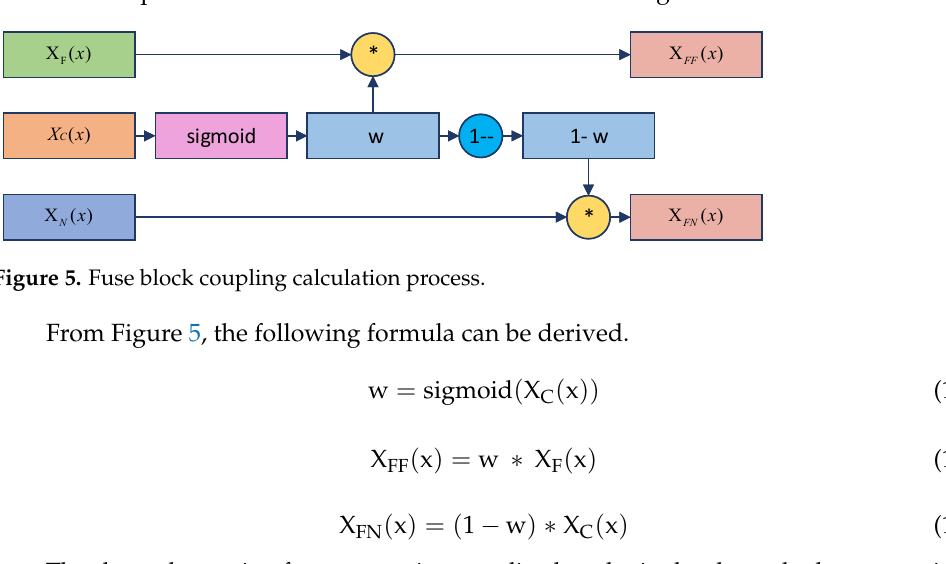
X ( ) FN x Figure 4. Schematic diagram of the fuse block. In Figure 4, X is the input for the module. Firstly, the channel attention module, flash attention module, and neighborhood attention module are, respectively, used to imple ‐ ment the channel attention feature map